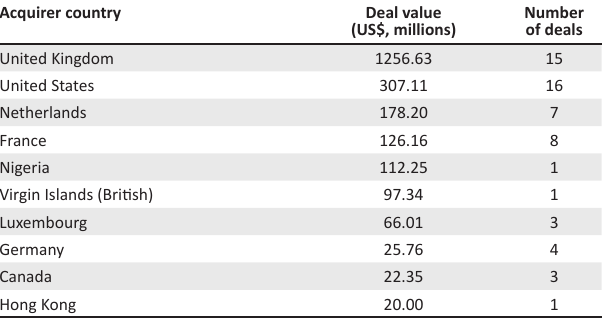
TABLE 9: Agricultural mergers and acquisitions inflows into South Africa by source country, 2003–2014. Acquirer